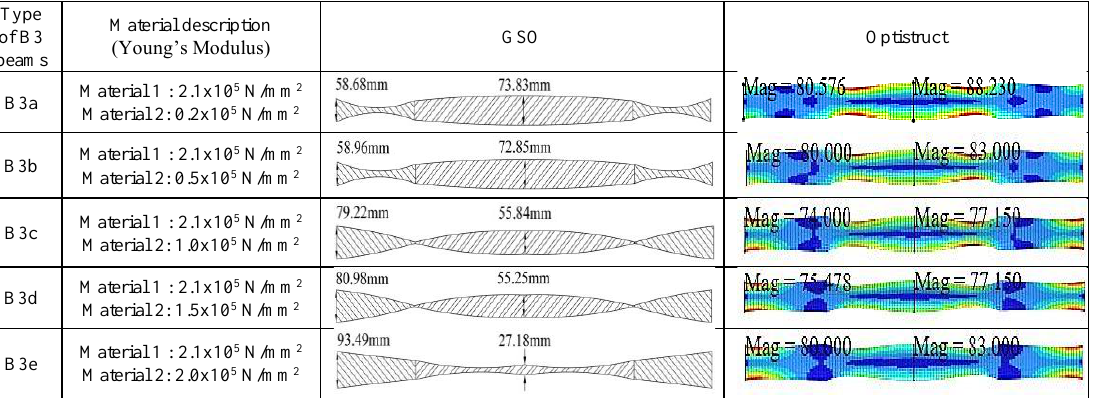
Table 5. Final optimized shape of B3a, B3b, B3c, B3d and